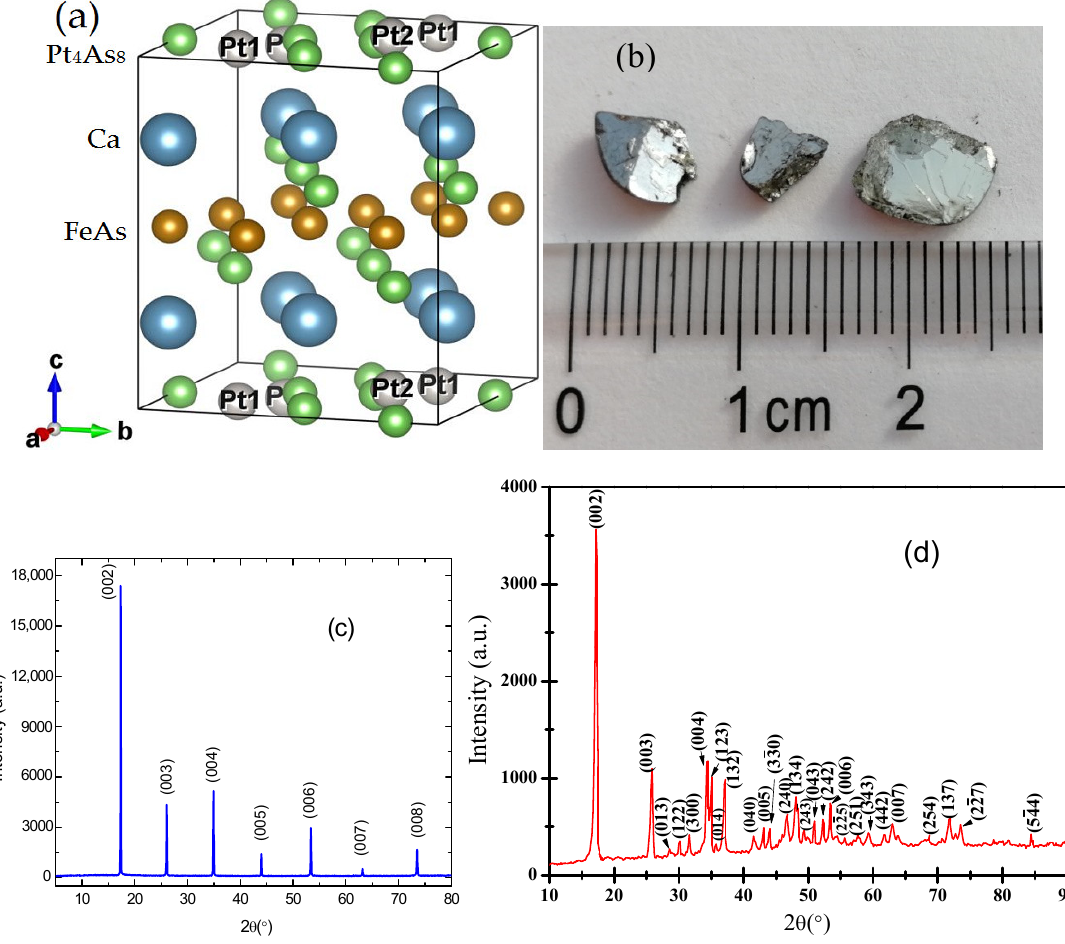
Figure 1. ( a ) Crystal structure of Ca 10 Pt 4 As 8 (Fe 2 As 2 ) 5 ; ( b ) as prepared Ca 10 (Pt 4 As 8 )(Fe 2−x Pt x As 2 ) 5 single crystals; ( c ) XRD spectrum with index peaks of Ca 10 (Pt 4 As 8 )(Fe 2−x Pt x As 2 ) 5 measured on single crystals along the c-axis at room temperature; ( d ) XRD spectrum of powder Ca 10 (Pt 4 As 8 )(Fe 2−x Pt x As 2 ) 5 at room temperature.